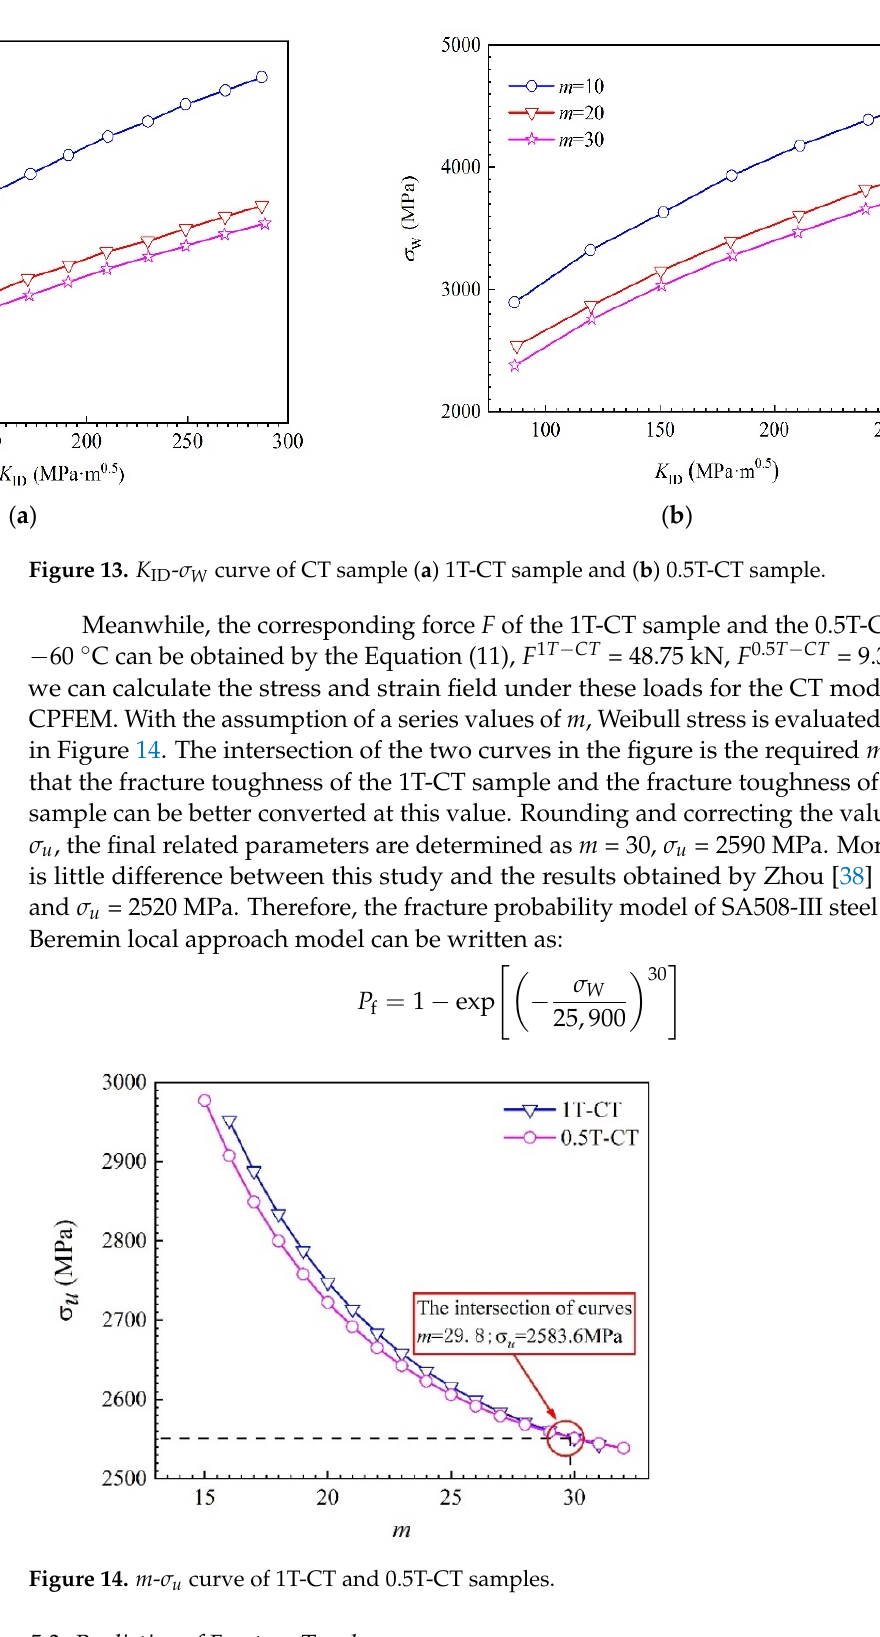
Figure 15. Fracture toughness conversion curves of 1T-CT and 0.5T-CT samples. The m and